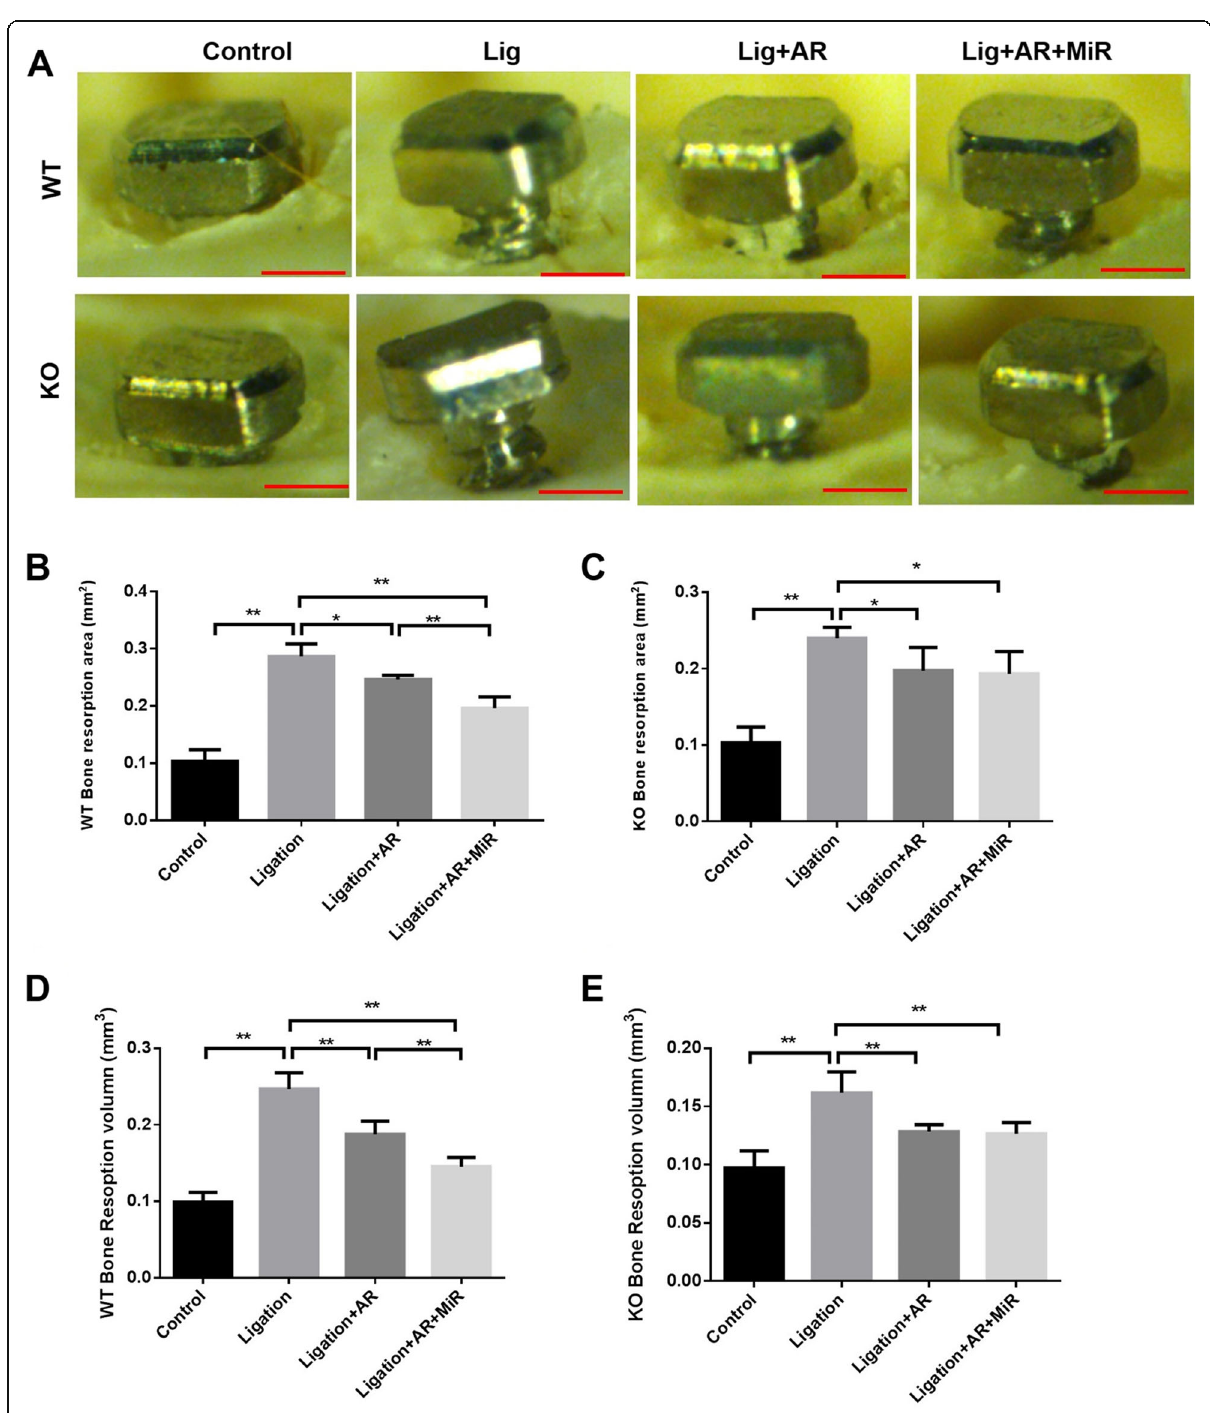
Fig. 2 Anti-RANKL and anti-RANKL+miR-146a treatments decreased ligature-induced bone resorption with different patterns in experimental peri- implantitis of WT and TLR2/4 KO mice. Buccal side images of the defleshed skulls were taken of the control (non-ligation) group, ligation (non- treatment) group, ligation with anti-RANKL antibody (ligation+AR) treatment group, and ligation with anti-RANKL antibody + miR-146a (ligation+A+MiR) treatment group in WT mice and TLR2/4 KO mice ( a ) (scale bar, 500 μ m). The bone resorption area based on these images was measured and analyzed for WT mice ( b ) and TLR2/4 KO mice ( c ) (mean ± SD, n = 6, * p < 0.05, ** p < 0.01, SEM, standard error of difference between two means). Three dimension (3D) images from μ CT were collected and analyzed for WT mice ( d ) and TLR4 KO mice ( e ) (mean ± SD, n = 6, * p < 0.05, ** p <